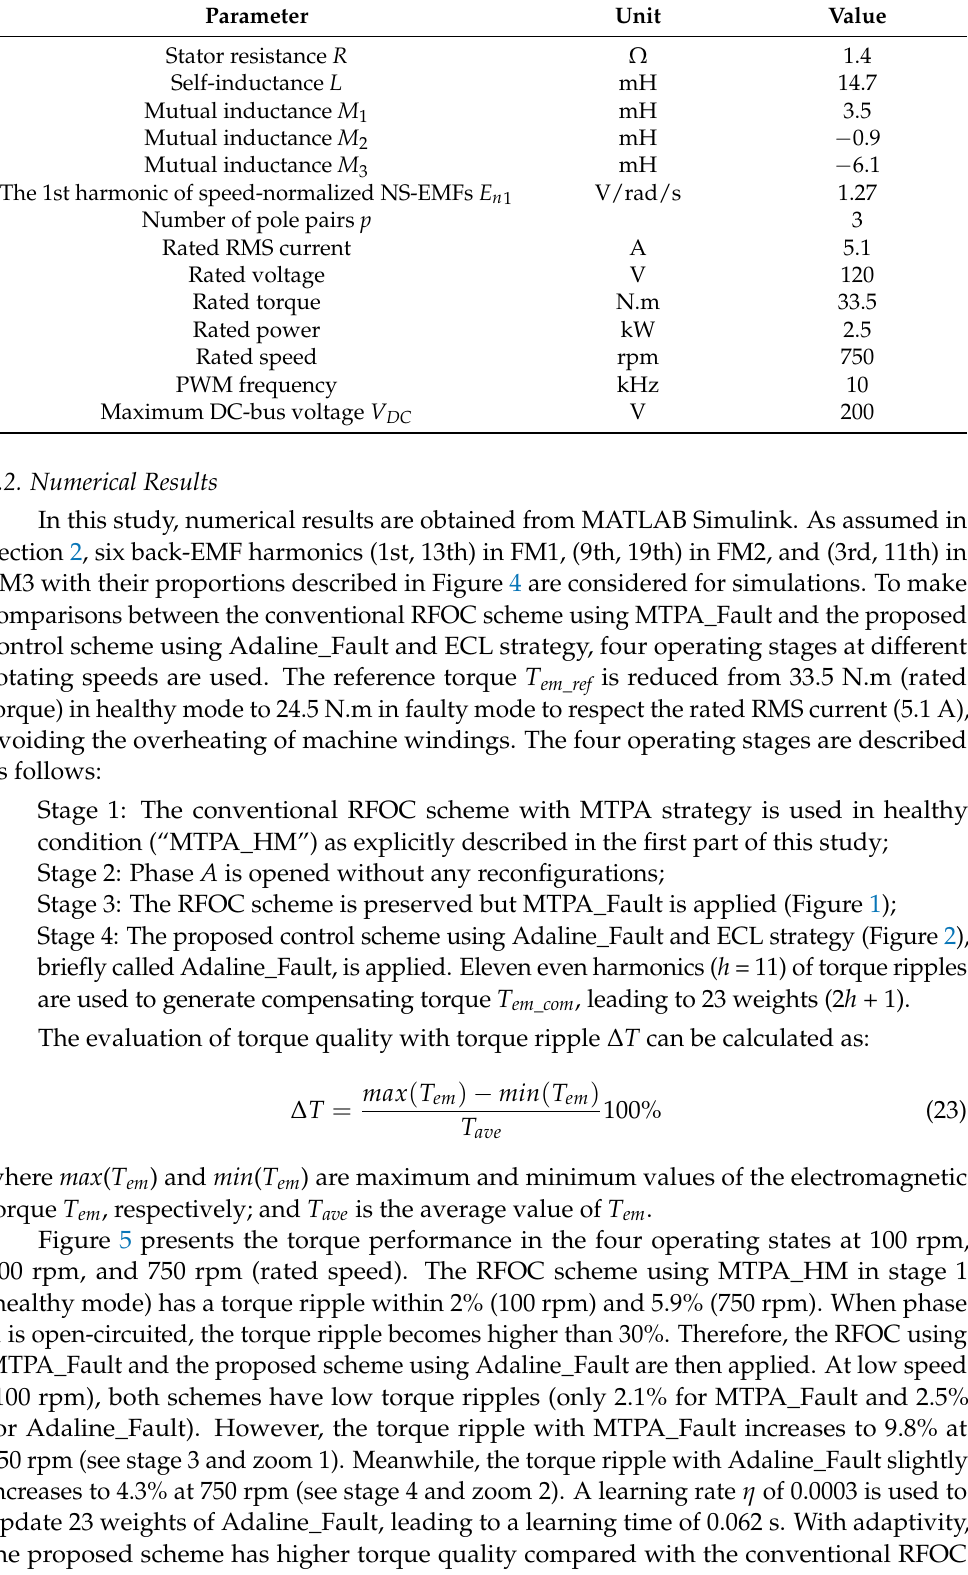
The 1st harmonic of speed-normalized NS-EMFs E n 1